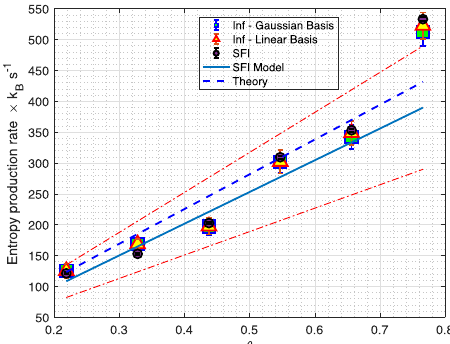
Fig. 2 The short-time inference scheme tested on experimental data. Test of our inference algorithm on experimental data for different values of the parameter A (or θ ) where A is the amplitude of the noise in the Ornstein – Uhlenbeck process de fi ned in Eq. (10) and θ is de fi ned in Eq. (13). The dark-blue dashed line corresponds to the theoretical value given by Eq. (14). The squares and triangles corresponds to the entropy production rate σ estimated from the experimental data using our thermodynamic uncertainty relation (TUR)-based inference scheme (Eq. (4)) with a Gaussian basis and a linear basis, and using Δ t = 0.1 ms. The error bars correspond to averages over eight independent realizations of duration 12.5 s. The circles correspond to σ estimated using the stochastic force inference scheme (SFI) 19 for the whole 100 s data set, and the error bars for these correspond to a self-consistent estimate of the inference error that the SFI provides 19 . The blue line corresponds to σ predicted by a model obtained from SFI (Supplementary Note 2), and the red dashed lines correspond to error bars for this SFI-based model. The parameters used in the experiment are as follows: the corner-frequency of the harmonic trap, f = 135 ± 10 Hz, relaxation time of the Ornstein – Uhlenbeck process c τ = 0.0025 s, temperature of the aqueous medium T = 298 K, and the rate 0 at which the trajectory is sampled: Δ t = 0.0001